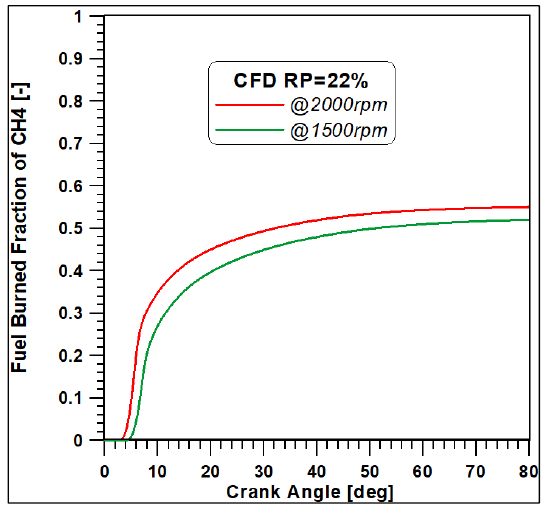
Figure 9. Methane burned fraction.